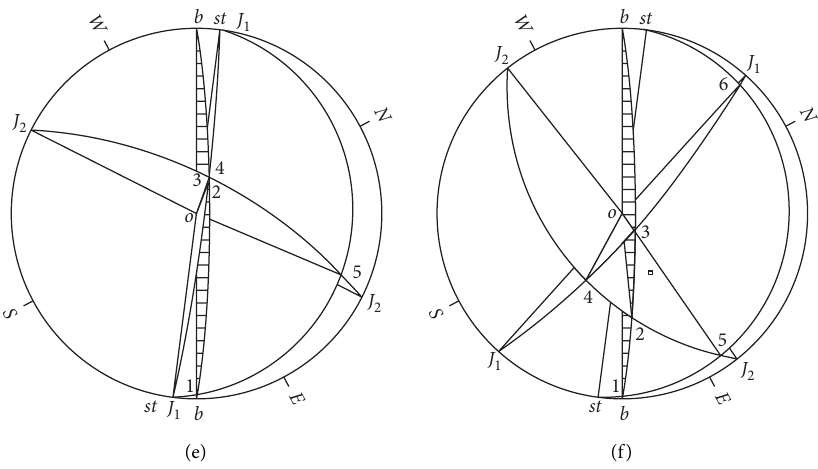
Figure 6: Analysis diagram of the stereographic projection. (a) W 1. (b) W 2. (c) W 3. (d) W 4. (e) W 5. (f) W 6.